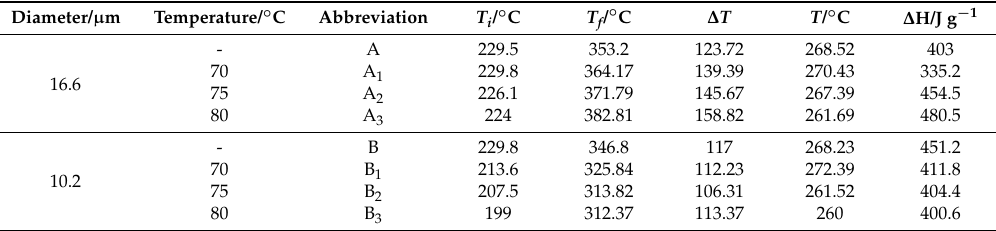
Table 2. DSC data of PAN fibers with different diameters after